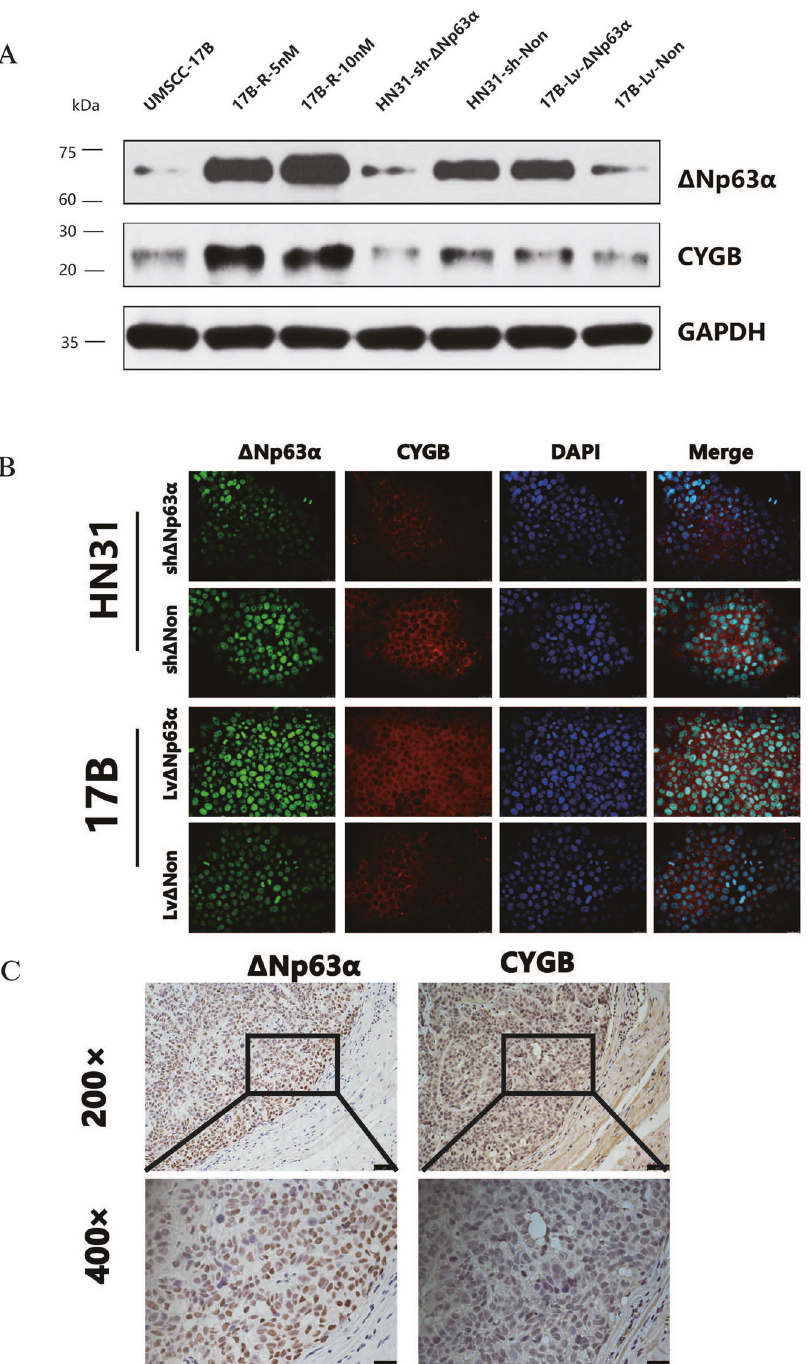
Fig. 6 Δ Np63 α can regulate the expression of CYGB. A . Western-blot was performed to analyze Δ Np63 α and CYGB proteins levels of UMSCC-17B 17B-R-5nM, 17B-R-10nM, HN31-sh Δ Np63 α , HN31-shNon, 17B-Lv Δ Np63 α , and 17B-LvNon. B . Four strains (HN31-sh Δ Np63 α , HN31- shNon, 17B-Lv Δ Np63 α and 17B-LvNon) were observed for Δ Np63 α (green) and CYGB (red) by immunostaining with antibodies. Nuclei were counterstained with DAPI (blue). Scale bar: 20 μ m. C . Immunohistochemistry of nude mice tumors was performed to show the location and intensity of Δ Np63 α and time of using this approach to illustrate the mechanism of that CYGB is the transcription target of Δ Np63 α using CHIP-seq, resistance to bortezomib in solid tumors, and to further explain and veri fi ed it by PCR. Furthermore, the detection of the activity of the relationship between the upregulation of Δ Np63 α in HNSCC the Δ Np63 α -regulated CYGB promoter by the dual-luciferase and the increase in resistance to bortezomib. Regarding the reporter gene upheld the existence and function of the Δ Np63 α – CYGB axis in HNSCC. We speculated that HNSCC cells regulation of CYGB, a previous study con fi rmed that non-coding sequence of CYGB promoter contains multiple conserved regions, employ a novel molecular mechanism to regulate resistance to and the genetic characteristics of these regions are often related bortezomib through the Δ Np63 α – CYGB – ROS axis. This is the fi rst